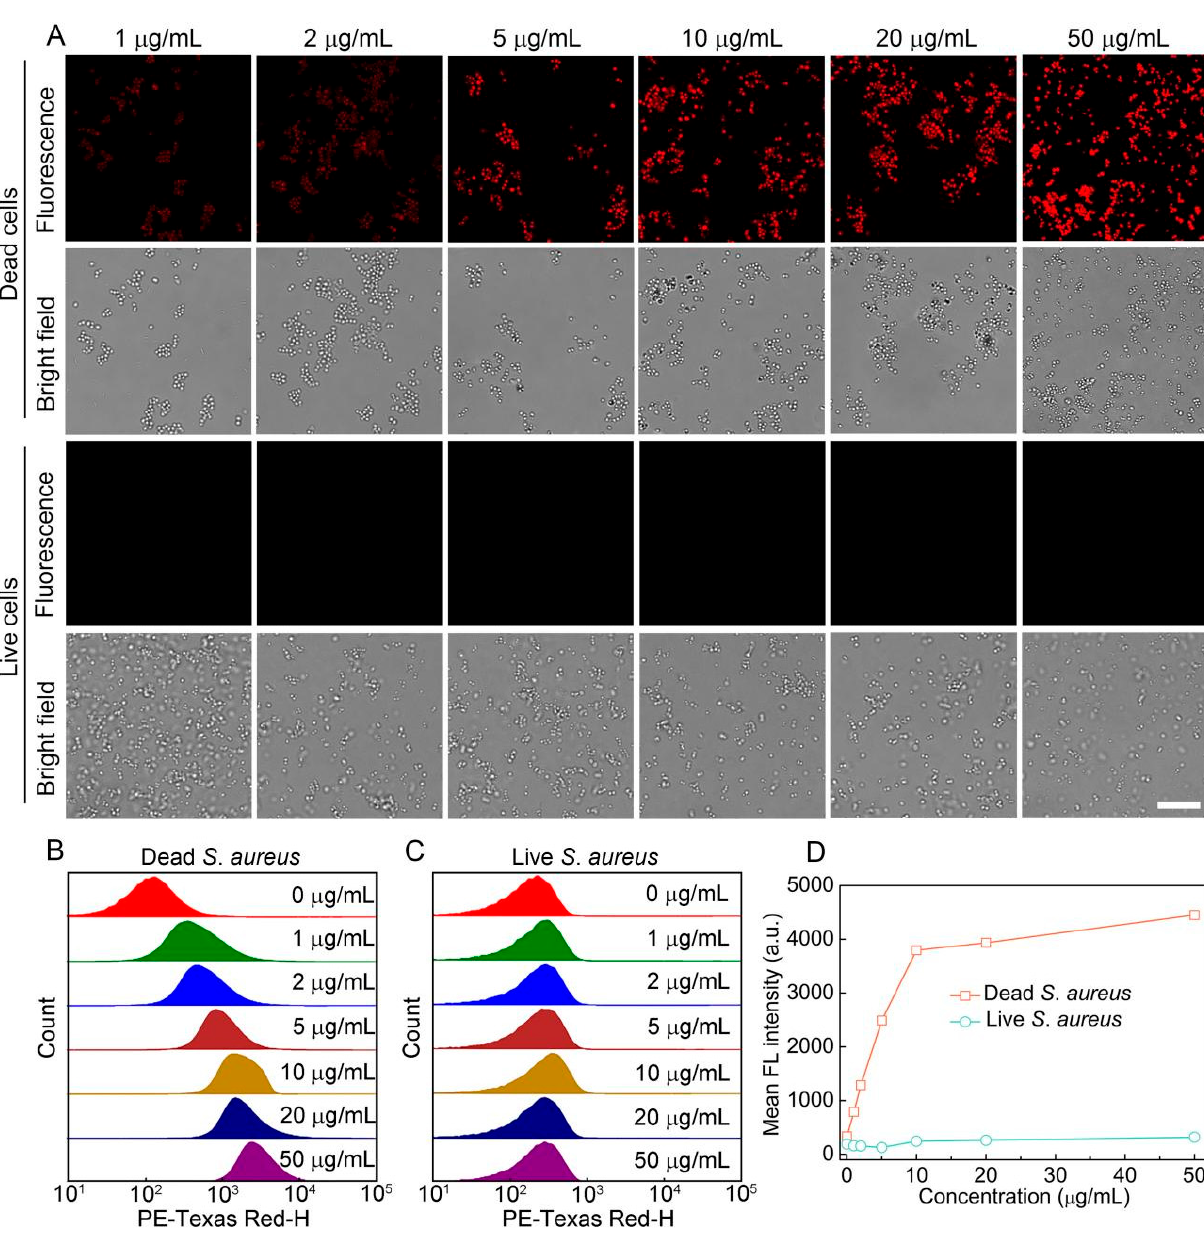
Figure 2. ( A ) Confocal images of dead and live S . aureus cells incubated with various concentrations of S ‐ OSiNDs for 30 s. Scale bar = 10 μ m. Flow cytometric results of the dead ( B ) and live ( C ) S . aureus cells incubated with different concentrations of S ‐ OSiNDs for 30 s and ( D ) corresponding quantitative mean fluorescence intensities derived from the flow cytometric results.